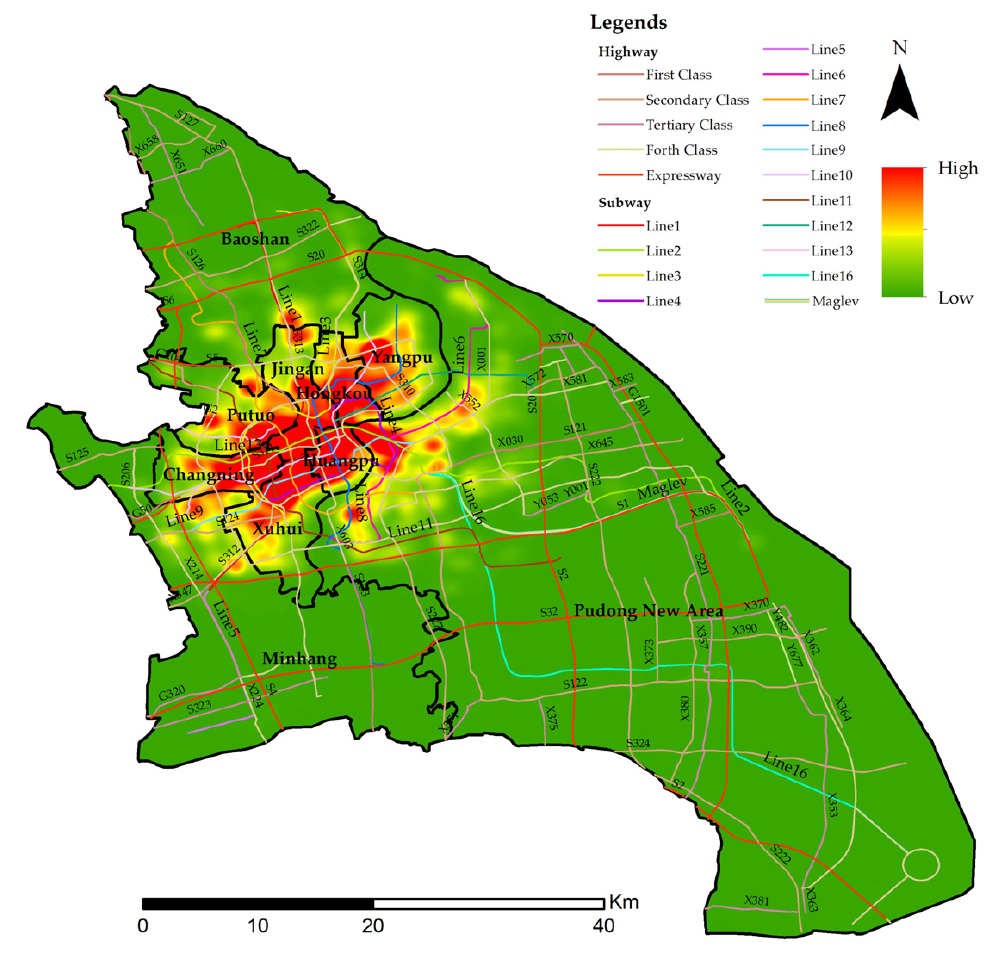
Figure 4. Check-in density in Figure 4. Check ‐ in density in Shanghai.